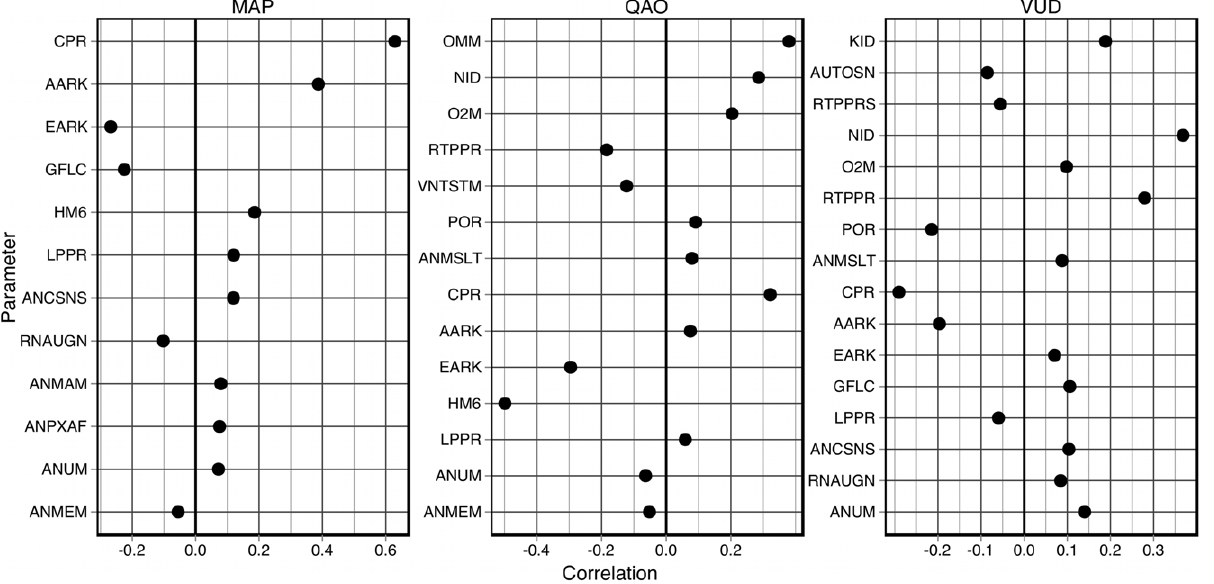
Figure 5. Significant correlations between model parameters and three key output variables. Correlations are shown for mean arterial pressure (MAP), cardiac output (QAO) and rate of urine production (VUD), where p v 0 : 05 and D corr D w 0 : 05 .